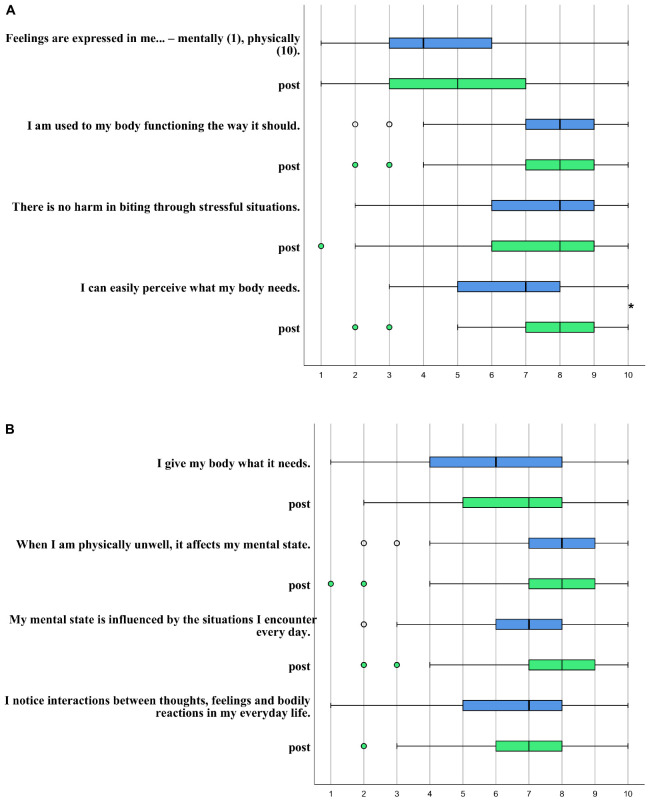
(A,B) Psychosomatic perceptions before (blue) and after (green, marked as “post”) the consultation. Boxplot from N = 118 participants. *p < 0.05. If not explicitly stated, the scale is rated between: Do not agree at all (1) – strongly agree (10).